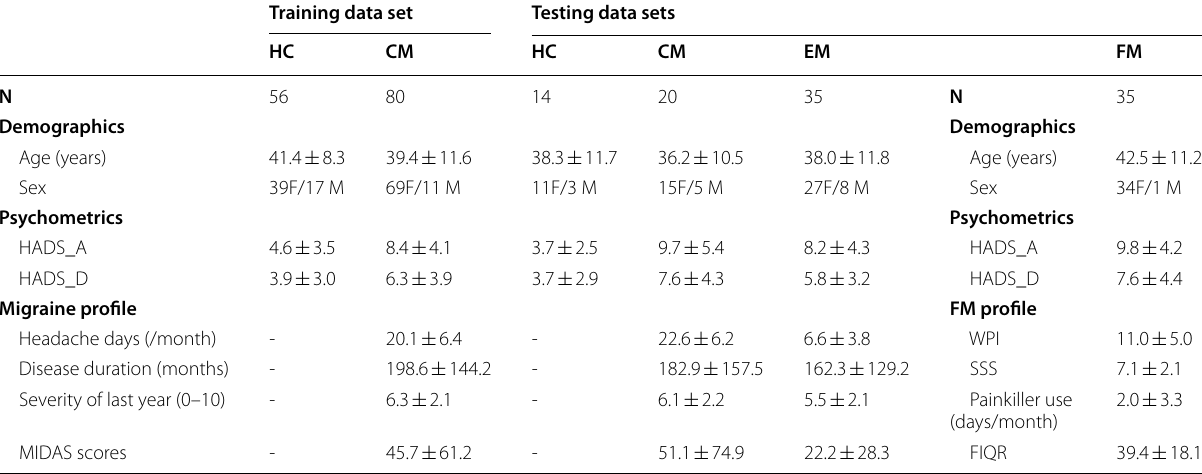
HC Healthy control, CM Chronic migraine, EM Episodic migraine, FM Fibromyalgia, HADS Hospital anxiety and depression score, A Anxiety, D Depression, MIDAS Migraine disability assessment, WPI Widespread pain index, SSS Symptom severity scale, FIQR Revised fibromyalgia impact questionnaire